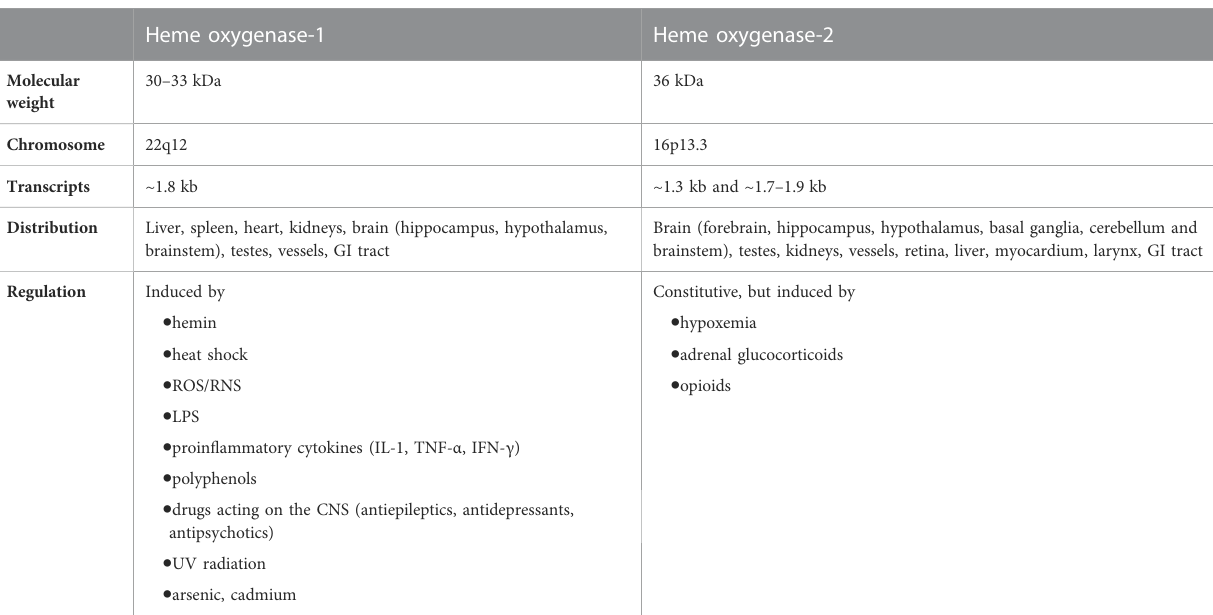
TABLE 1 Main features of heme oxygenase